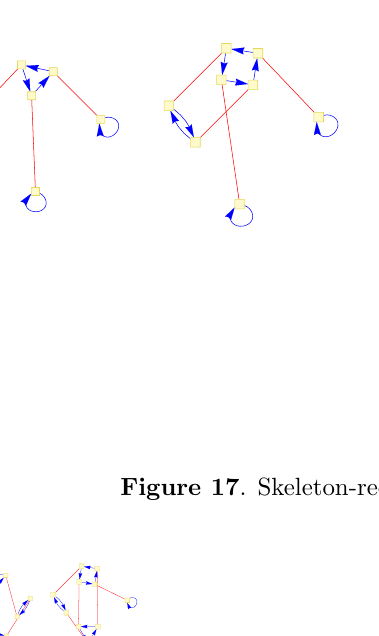
Figure 16 . Skeleton-reduced diagrams of ( G 4 ) connected (3 ; 3 ; 3 ; 3).